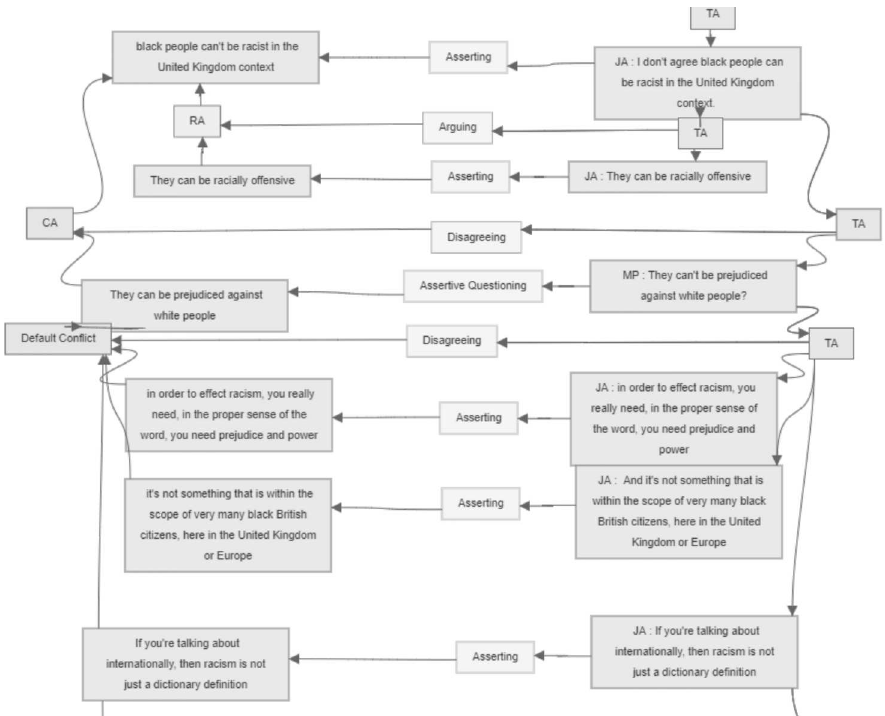
Figure 3. An illustration of corpus analysis for modelling debate